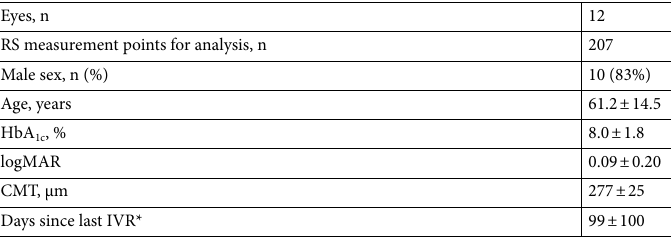
Table 1. Characteristics of the study population. The data are presented as the mean ± standard deviation or as the number (percentage). *Seven of 12 patients had a history of IVR. RS retinal sensitivity, CMT central